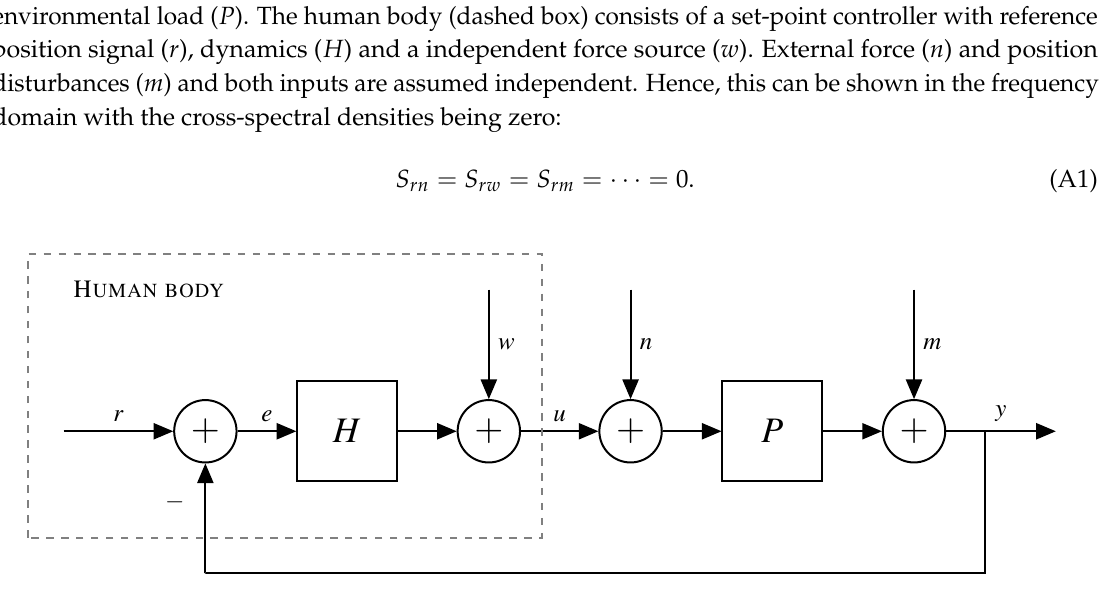
Figure A1. Closed loop representation of human ( H ) load ( P ) interaction. The human body (dashed rectangle) is modeled as a setpoint controller, dynamics ( H ) and an independent active force generator ( w ). Independent force ( n ) and position disturbances ( m ) are